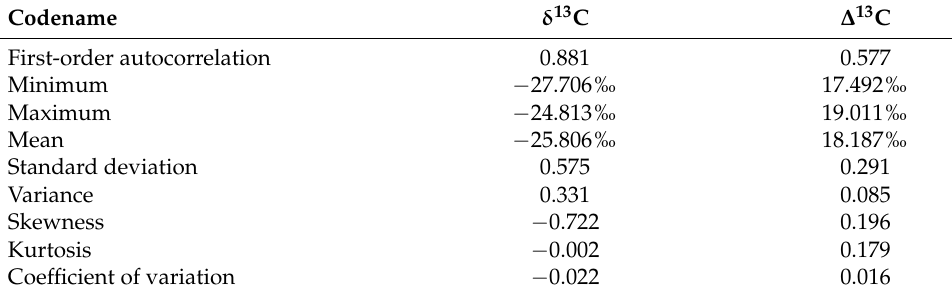
Table 2. The statistics of tree-ring stable carbon isotope